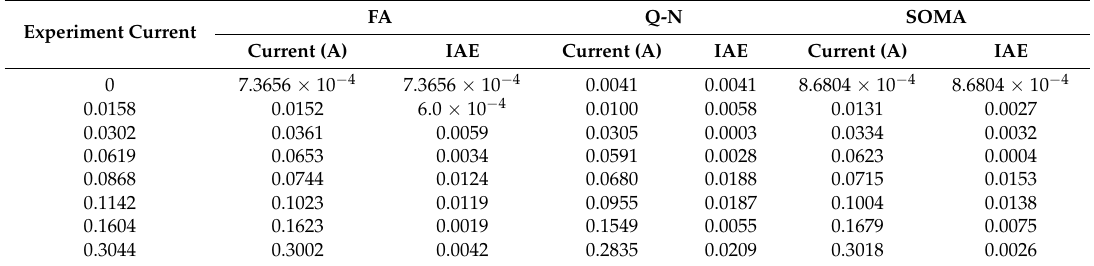
Table 10. Comparison between the calculate results of flexile silicon a-Si:H solar cell.